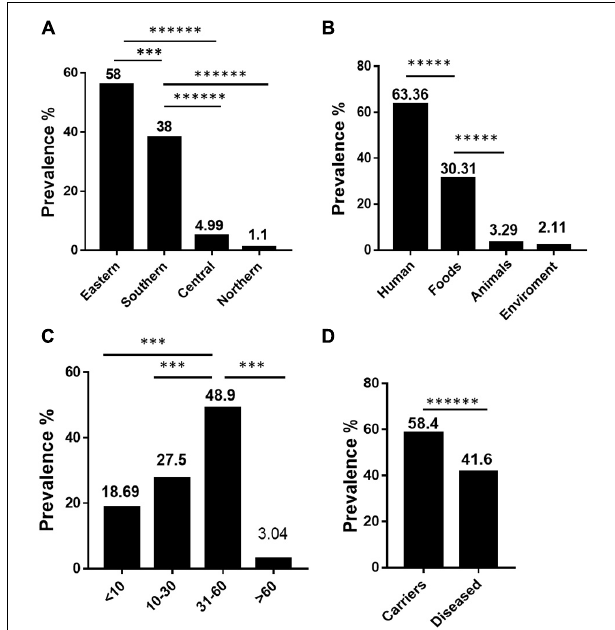
FIGURE 3 | The prevalence and dynamics among S. Rissen isolates examined in this study. (A) Difference in prevalence of S. Rissen isolates collected from different geographical parts. (B) Difference in prevalence of S. Rissen isolates collected from different origins. (C) Difference in prevalence of S. Rissen isolates collected from different human age groups. (D) Difference in prevalence of S. Rissen between the asymptomatic carriers and diseased patients. P- values less than 0.05 were considered statistically significant. Y -axis revealed to the prevalence %. The threshold of significance for the P -values indicated as follows: ∗∗∗∗∗∗ P < 0.0001; ∗∗∗∗∗ P < 0.0001; ∗∗∗ P < 0.001.